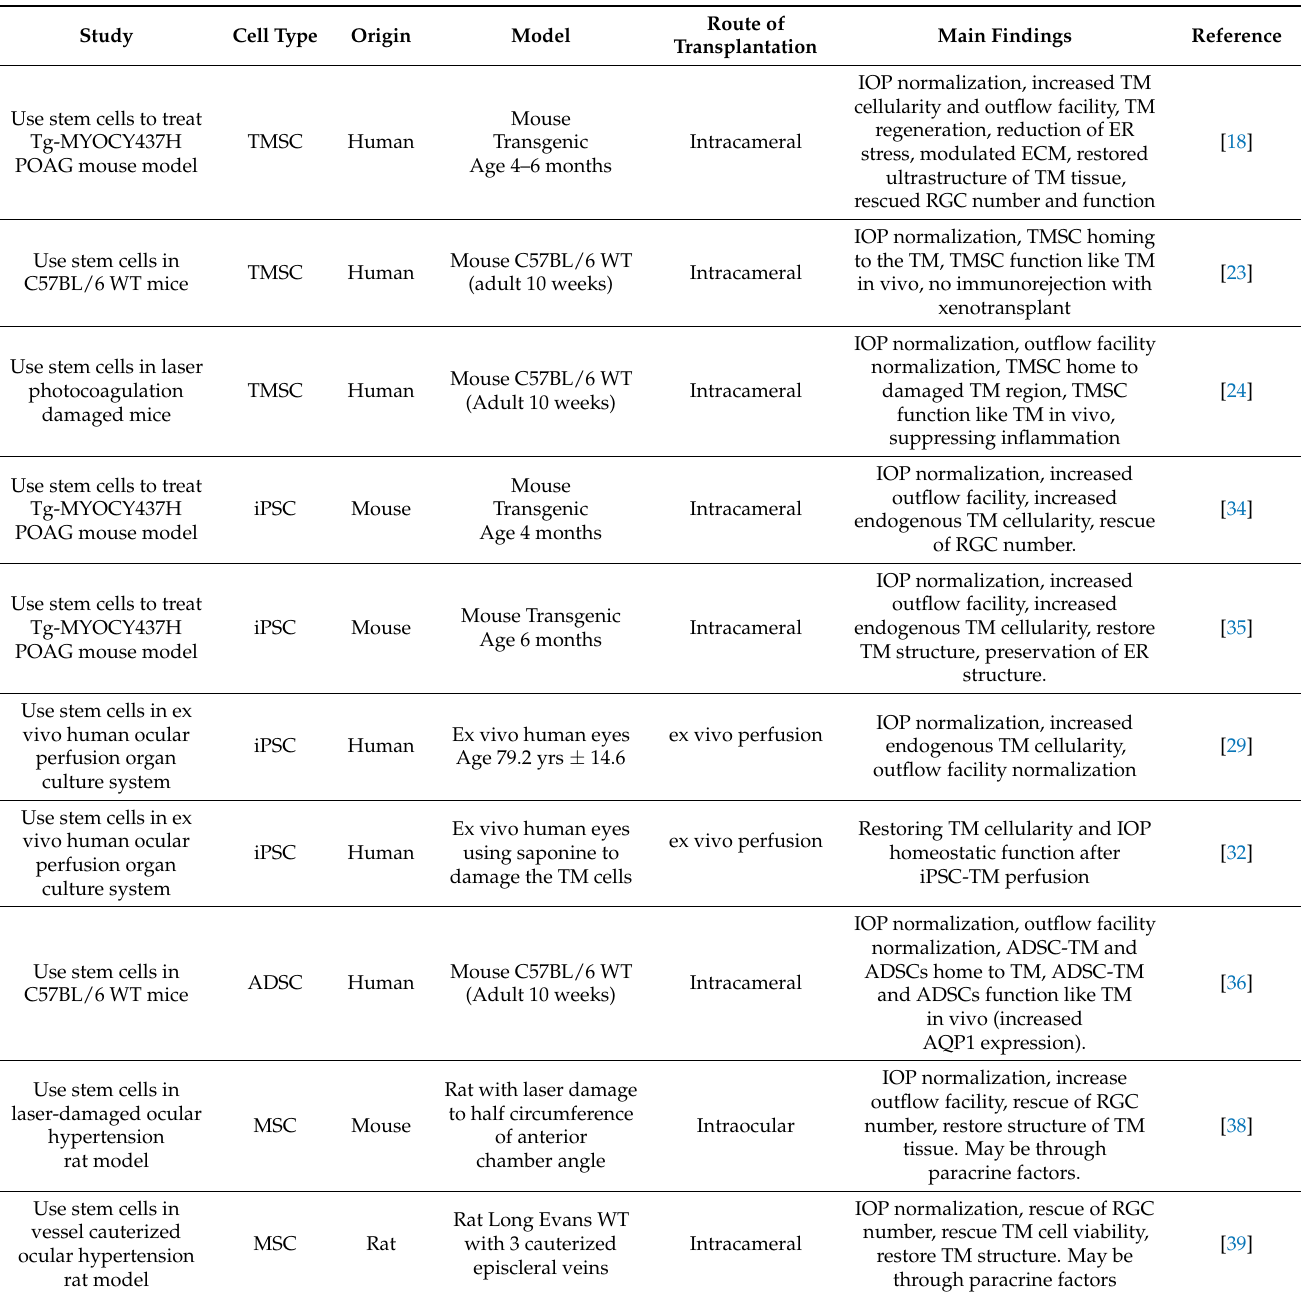
Table 1. Studies involving the use of different stem cells for glaucoma